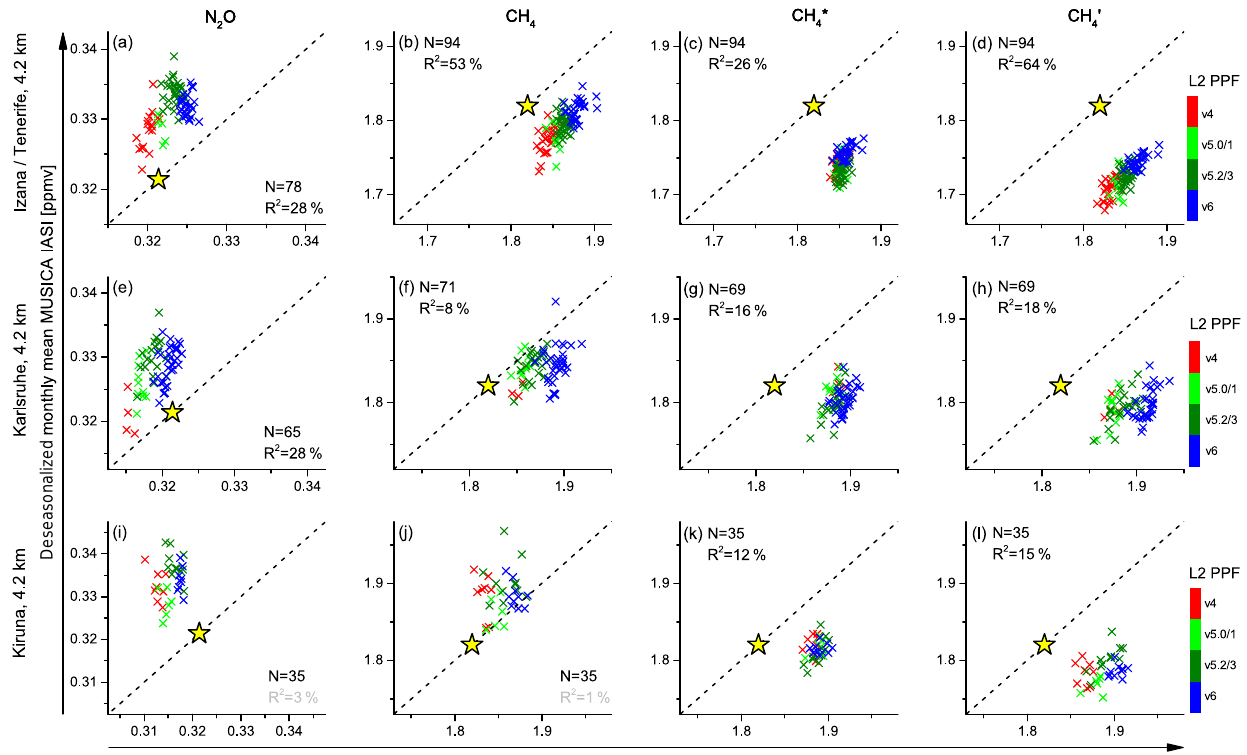
Figure 17. Same as Fig. 16, but for MUSICA IASI products (4.2km retrieval) and coinciding NDACC FTIR product (4.2km retrieval): (a– d) for the surroundings of Tenerife Island; (e–h) for the surroundings of Karlsruhe; (i–k) for the surroundings of Kiruna; (a) , (e) and (i) for N 2 O; (b) , (f) and (j) for CH 4 ; (c) , (g) and (k) for CH ∗ ; and (d) , (h) and (l) for CH (cid:48) . R 2 values in black indicate significant positive correlations 4 4 (95% confidence level) and grey indicate no